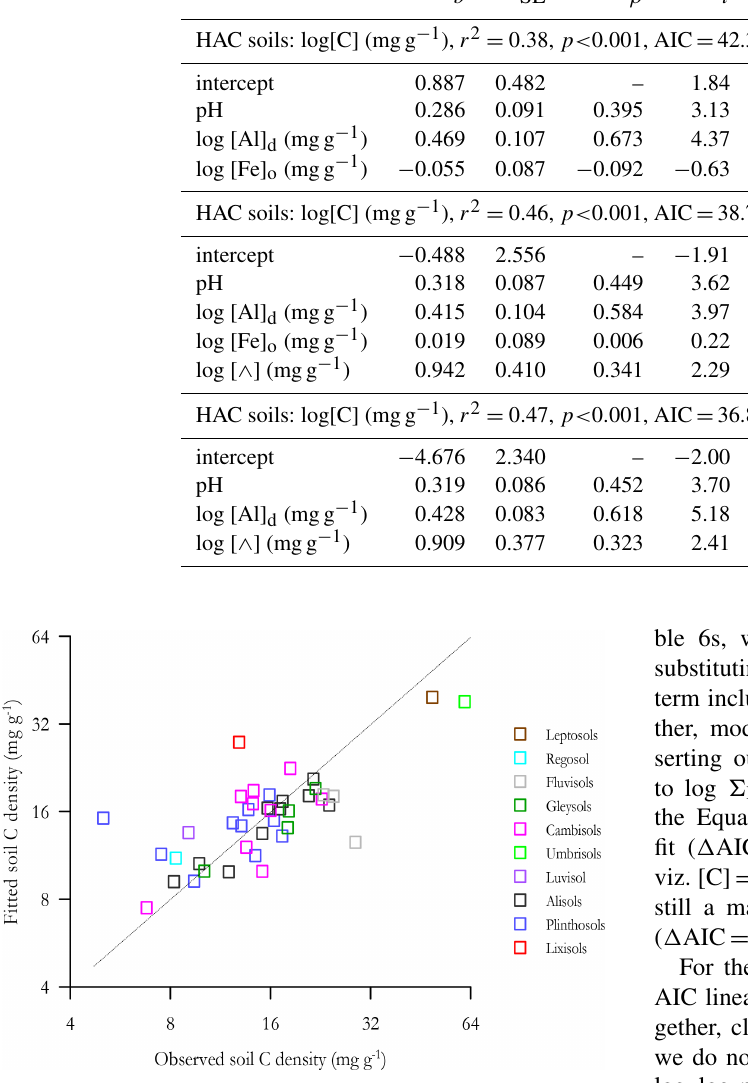
Figure 8. Fitted vs. observed SOC densities for regression model 7v (Table